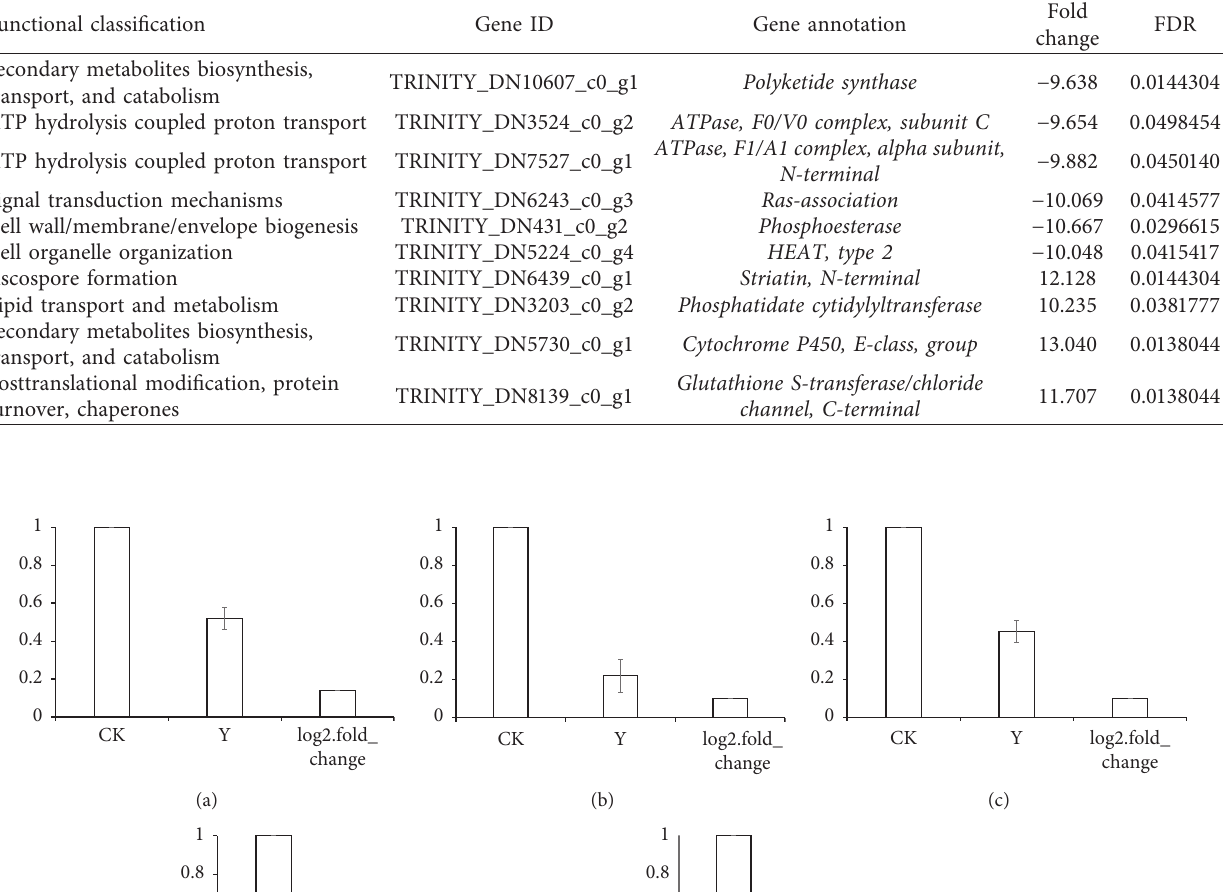
Table 4: Differentially expressed genes of P. expansum treated with M. guilliermondii (Y) and P. expansum (CK). FDR < 0.05 and log change ≥ 2 were considered statistically significant.